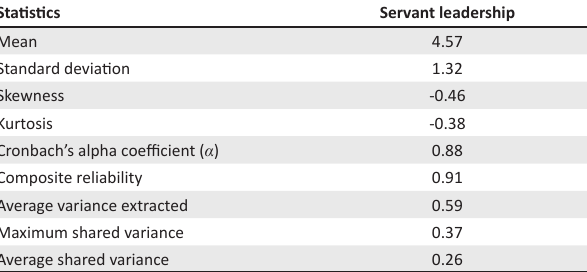
TABLE 5: Descriptive statistics, Cronbach’s alpha coefficient, and convergent and discriminant validity of the unidimensional construct and servant leadership. Statistics Servant